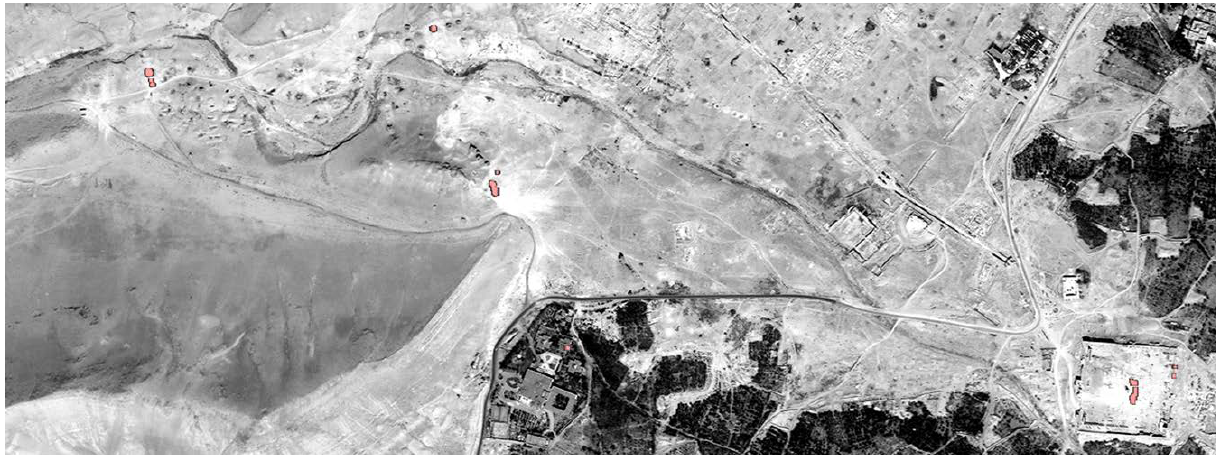
Figure 5. Post-processed change map overlaid on the 2 nd of September 2015 WorldView-2 image (©European Space Imaging / DigitalGlobe).